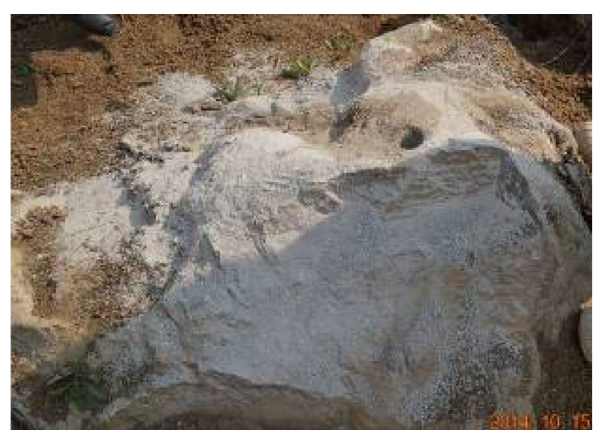
Fig. 8 Natural rock specimen from the quarry